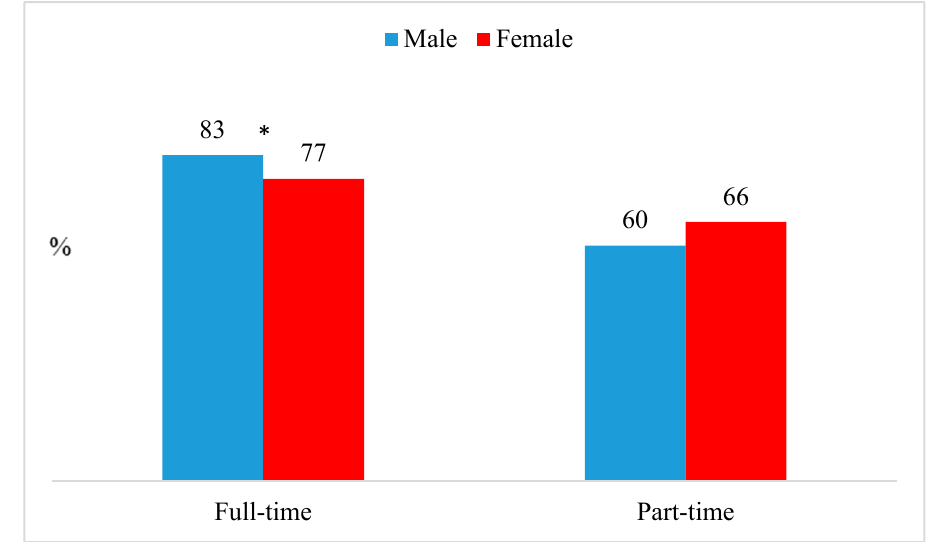
Figure 4. Proportion of doctoral graduates with a permanent job by gender and working hours in 2013 (* p < 0.5).